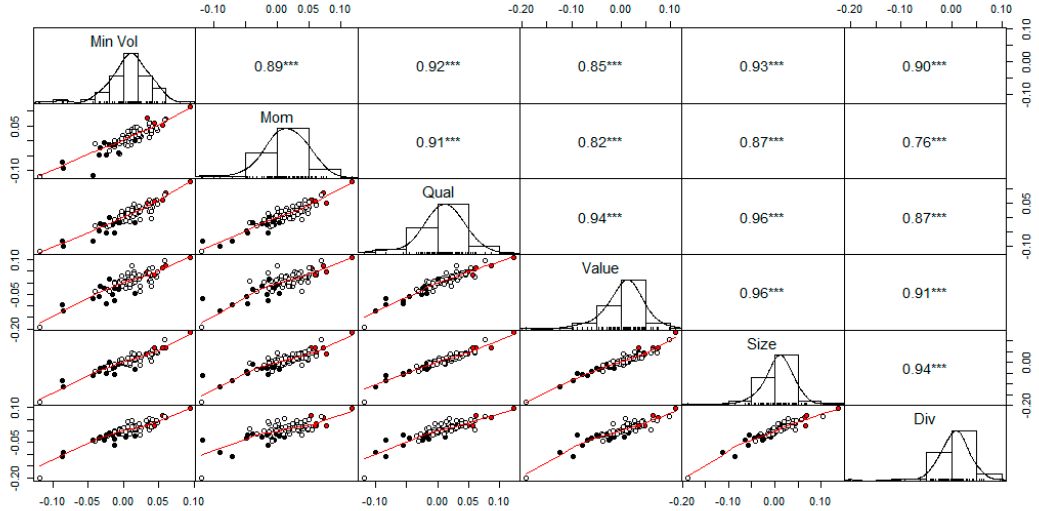
Figure 4. Bivariate scatter plots below the diagonal, histograms on the diagonal, and the Pearson correlation above the diagonal. Points represent the grouping variables G (red), L (black), and N (white). Source: our elaboration on data. Period: January 2014–May 2020. p -value ≤ 0.001 (***).